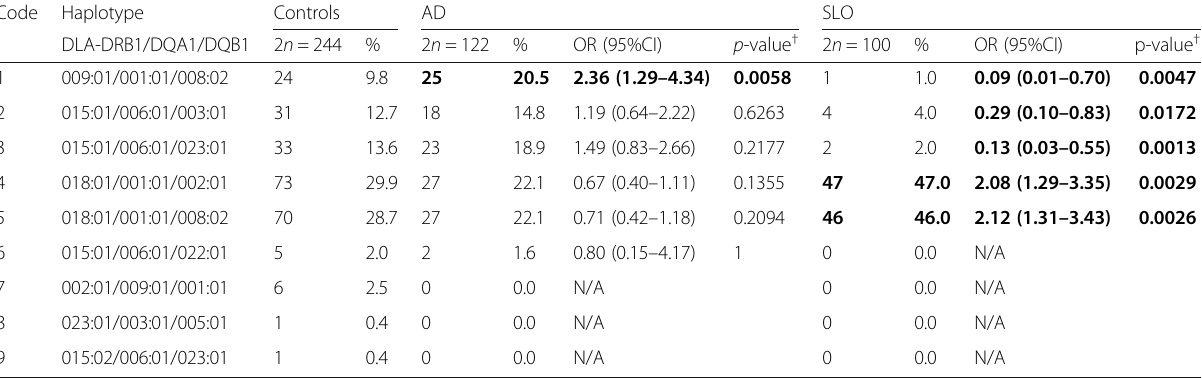
Table 2 Frequency, code, and odds ratio (OR) with 95% confidence interval (CI) of each three-locus haplotype observed in healthy, Addisonian (AD) and symmetrical lupoid onychodystrophy (SLO) bearded collies Code Haplotype